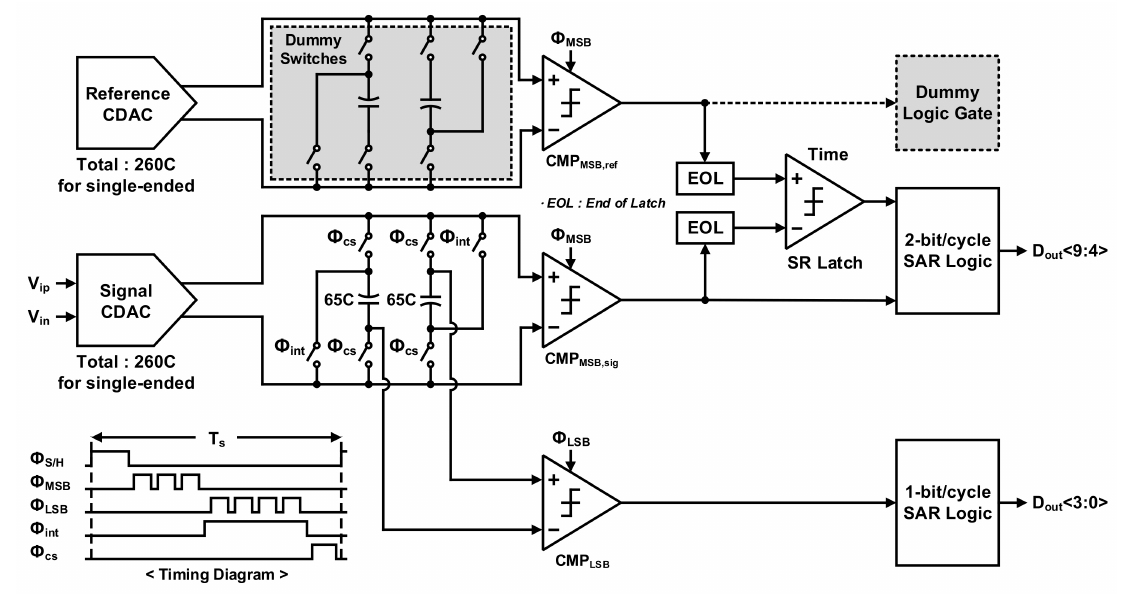
Figure 6. Top-level implementation of proposed